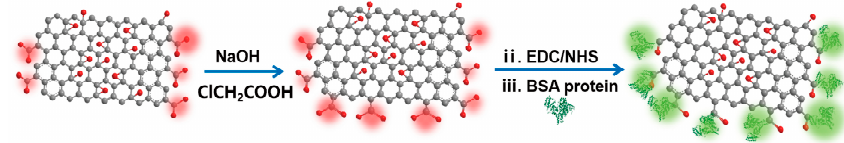
Figure 1. Preparation process of GO@BSA.